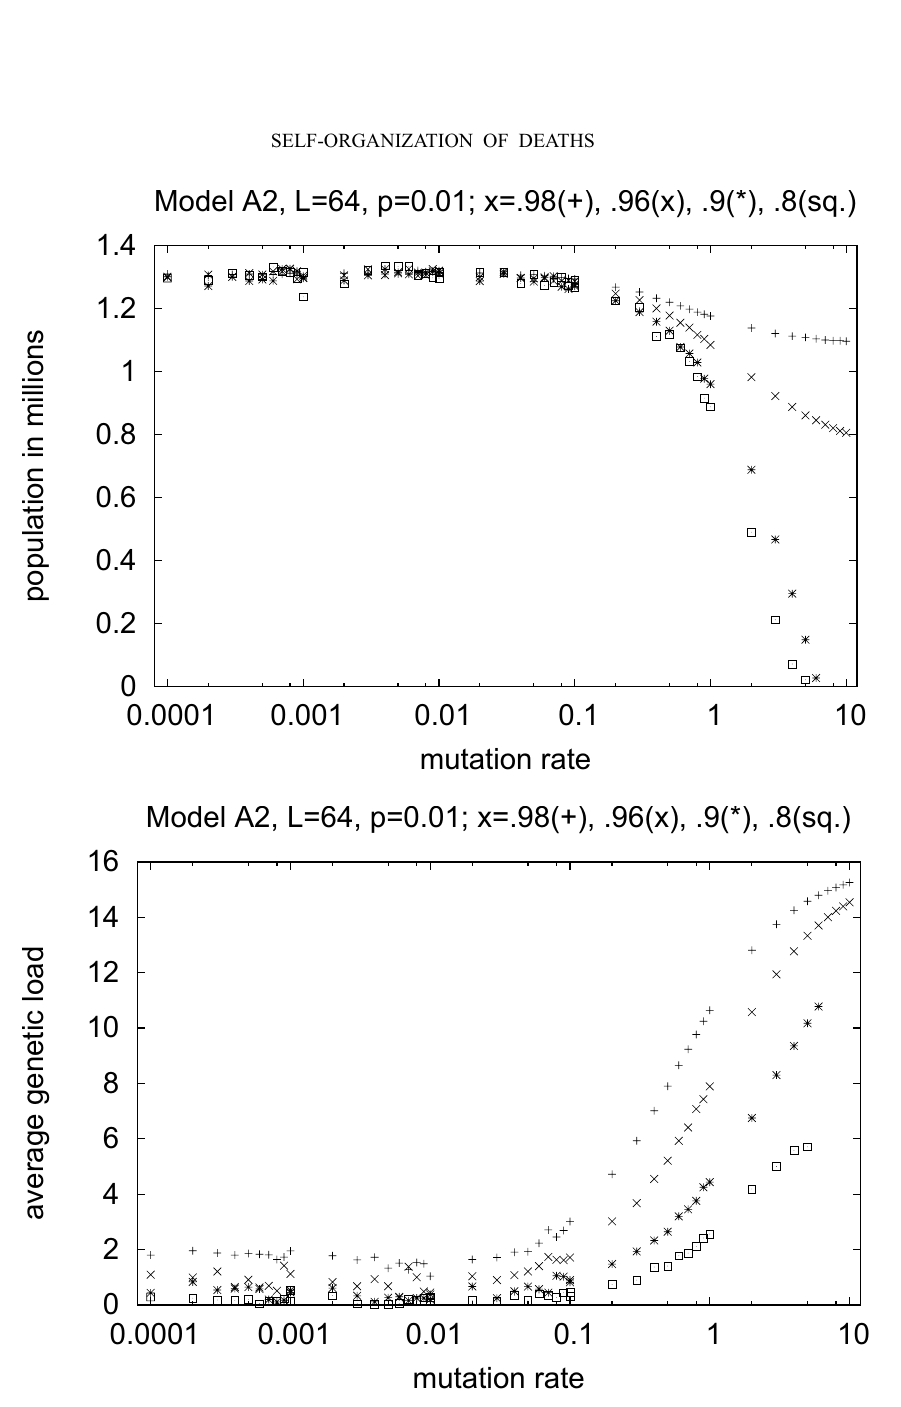
Fig. 3 – Model A2. As Figure 1 but with modified recessiveness and smaller x